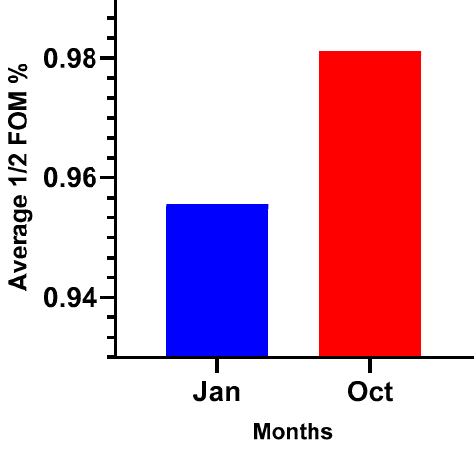
Processes 2020 , 8 , x FOR PEER REVIEW Figure 10. The plot of average Half Figure of Merit ( 1 / 2 FOM) with charging hours. Figure 10. The plot of average Half Figure of Merit (½ FOM) with charging hours.